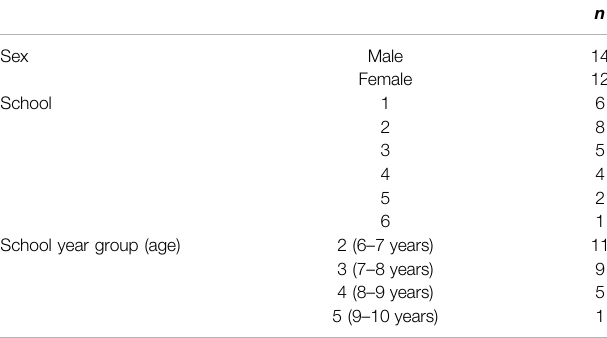
TABLE 4 | Demographic characteristics of the